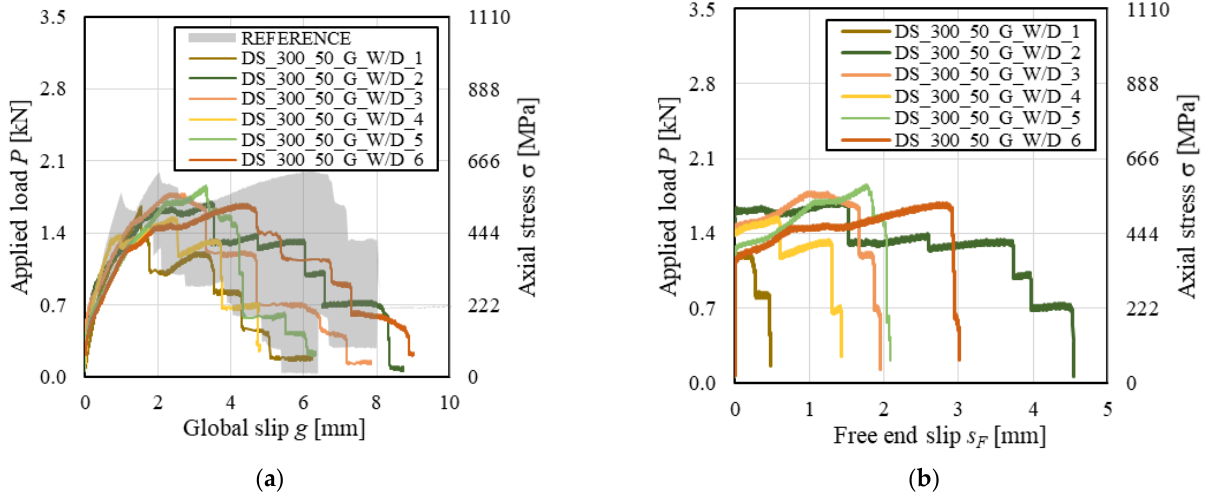
Figure 11. ( a ) P-g and ( b ) P-s F responses of FRCM-masonry joints with glass fiber textile.